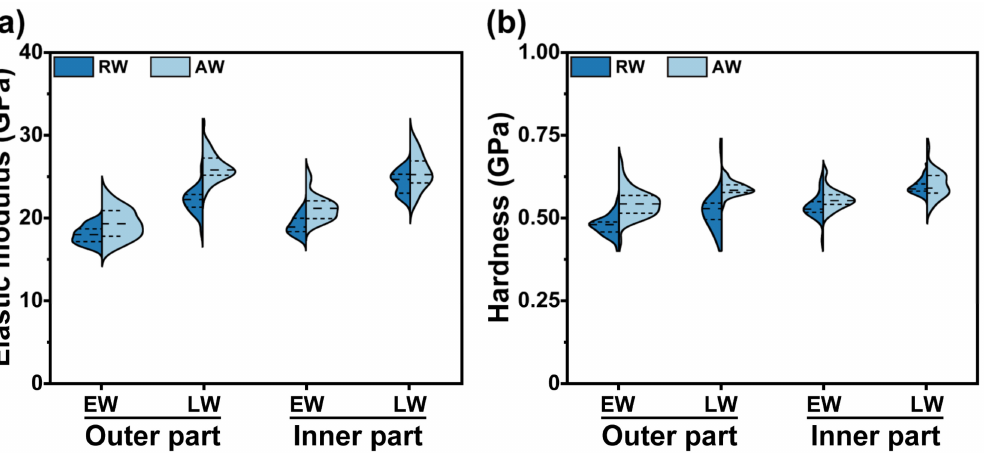
Figure 6. Reduced elastic modulus and hardness of the S 2 layer in tracheid cell walls of recent larch woods and ancient architectural woods. ( a ) Reduced elastic modulus. ( b )